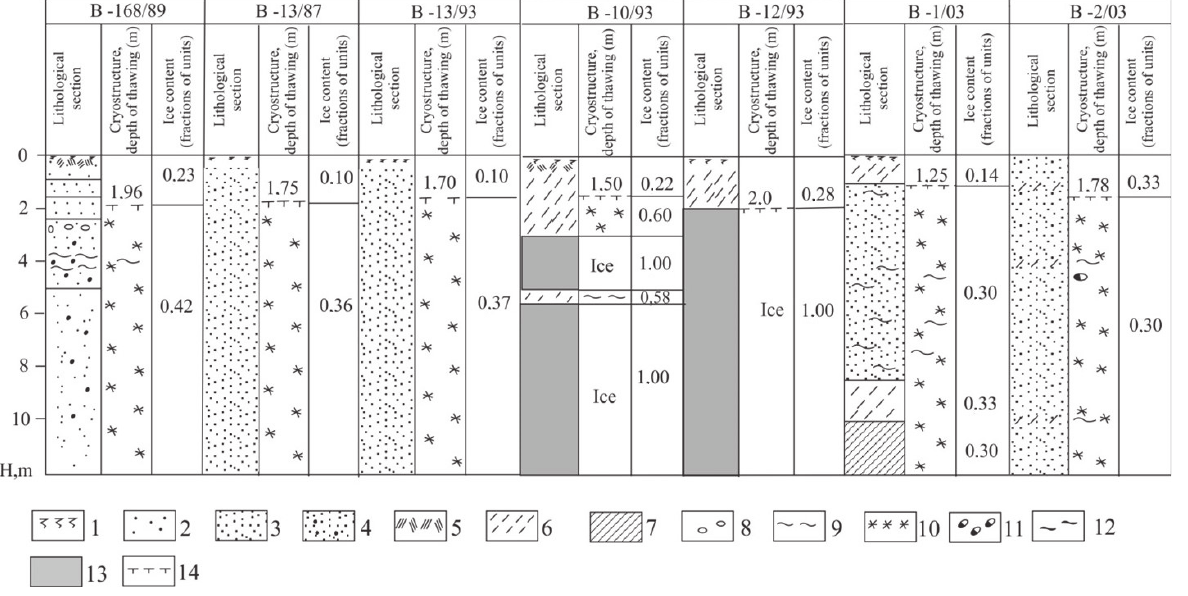
Figure 5. Borehole logs from floodplain (B ‐ 168/89), sand ridge (B ‐ 13/87, B ‐ 13/93), and inter ‐ alas (B ‐ 10/93, B ‐ 12/93, B ‐ 1/03, B ‐ 2/03) terrain units. Lithology: (1) turf, (2) medium sand, (3) fine sand, (4) poorly sorted sand, (5) peat, (6) silty sand, (7) silt, (8) small pebbles, (9) mud. Cryostructure: (10) massive, (11) crustal, (12) layered, (13) ice. Other notations: (14) permafrost table.